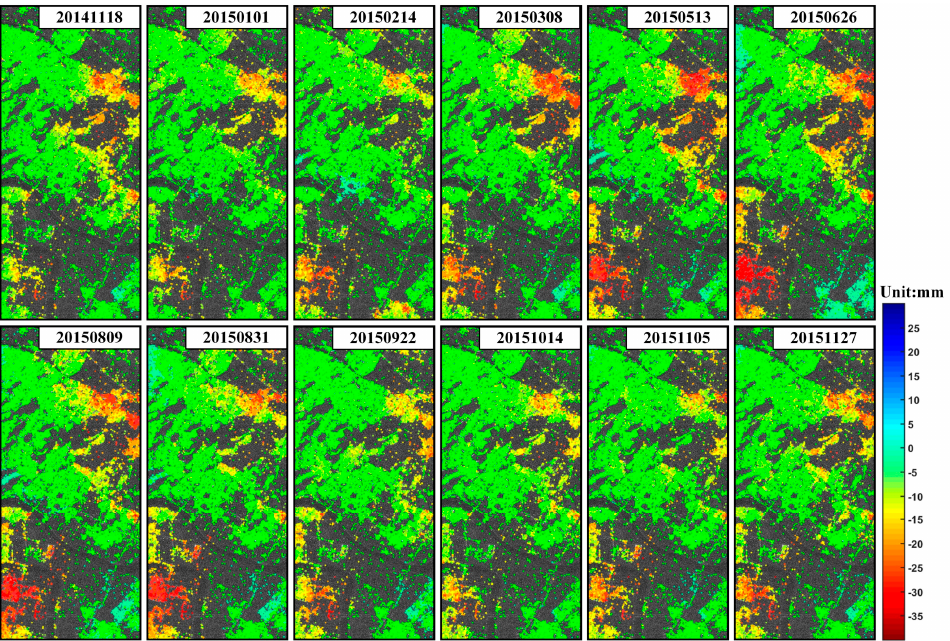
Figure 7. Time series deformation of Lungui Highway based on the seasonal model (referenced to 27 October 2014).